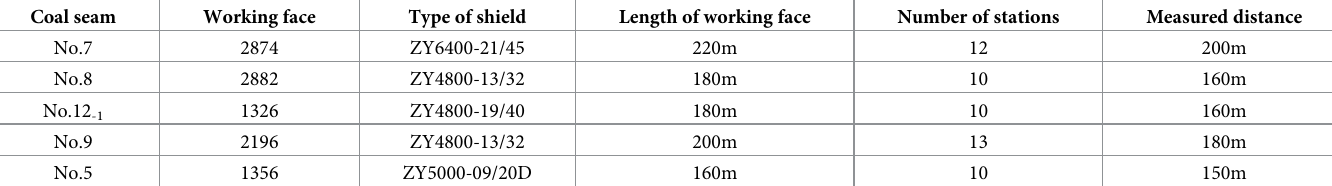
Table 16. Overview of the working faces in each coal seam.